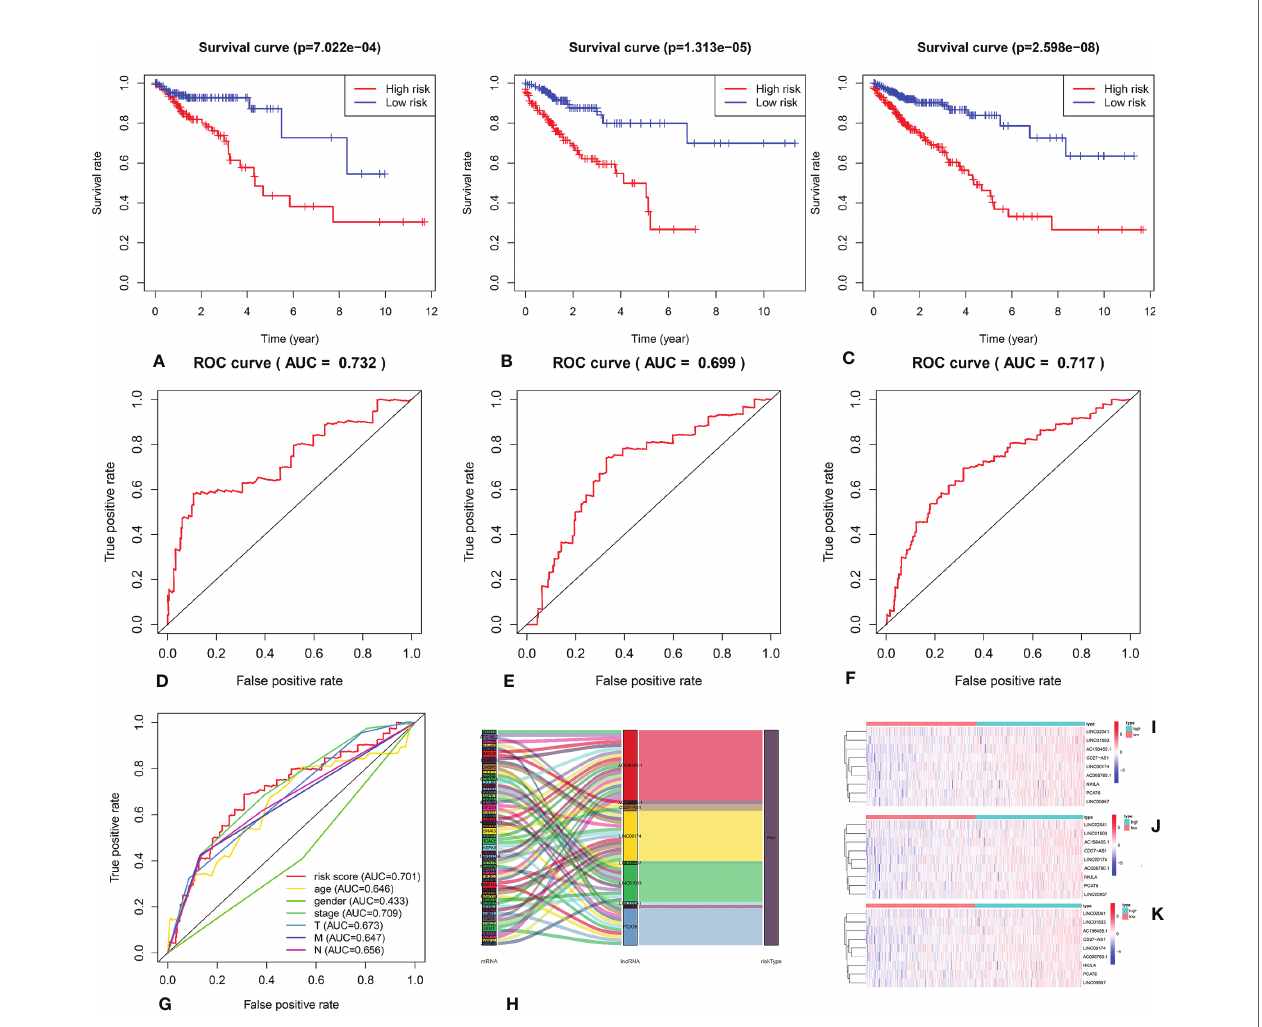
receiver operating characteristic (ROC) curve of nine ARlncRNA risk score and clinicopathological parameters (age, gender, clinical stage, and TNM stage). (H) The Sankey diagram shows the connection degree between the 53 mRNAs and 9 ARlncRNAs. (I – K) The heatmap of the nine ARlncRNA expression value in low- and high-risk score groups among train set, validation set, and all patients. Red to blue indicates a trend from high to low